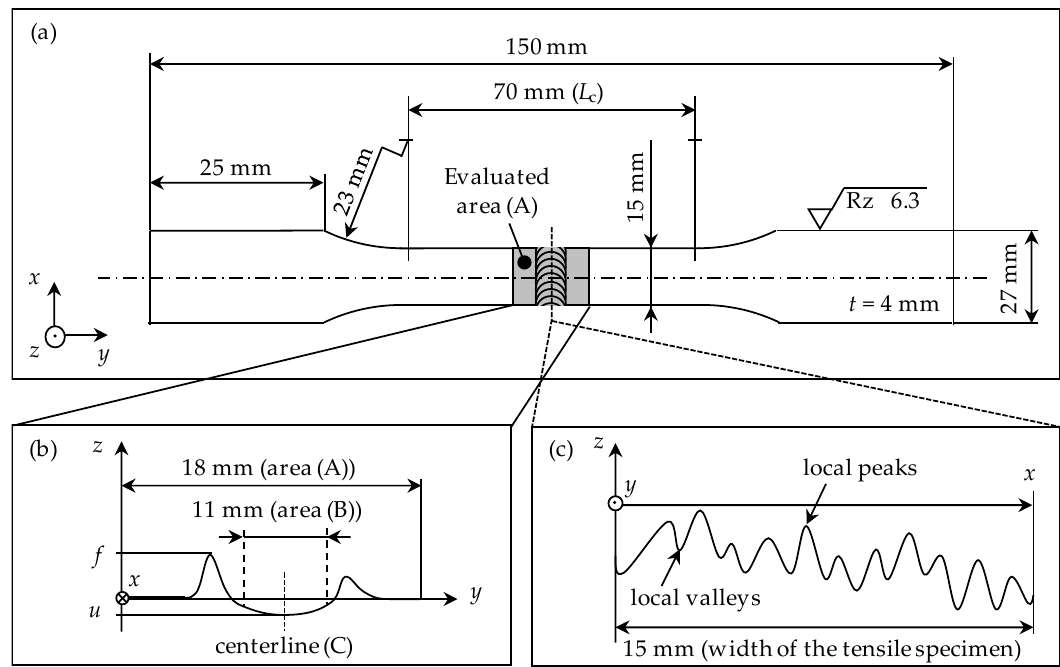
Figure 2. ( a ) Geometry and dimensions of the tensile specimens; ( b ) the evaluated surface topography; ( c ) the topography along the centerline of the weld. Table 1. Surface characteristics, which were correlated to the mechanical